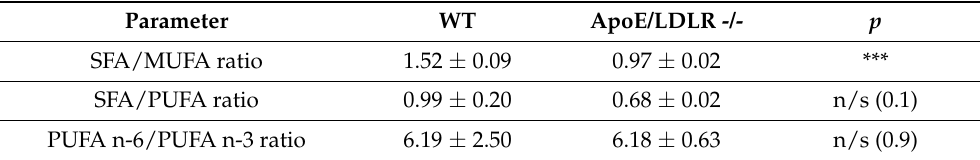
Table 2. Enhanced SFA/MUFA ratio in ApoE/LDLR -/- mice serum. Results presented